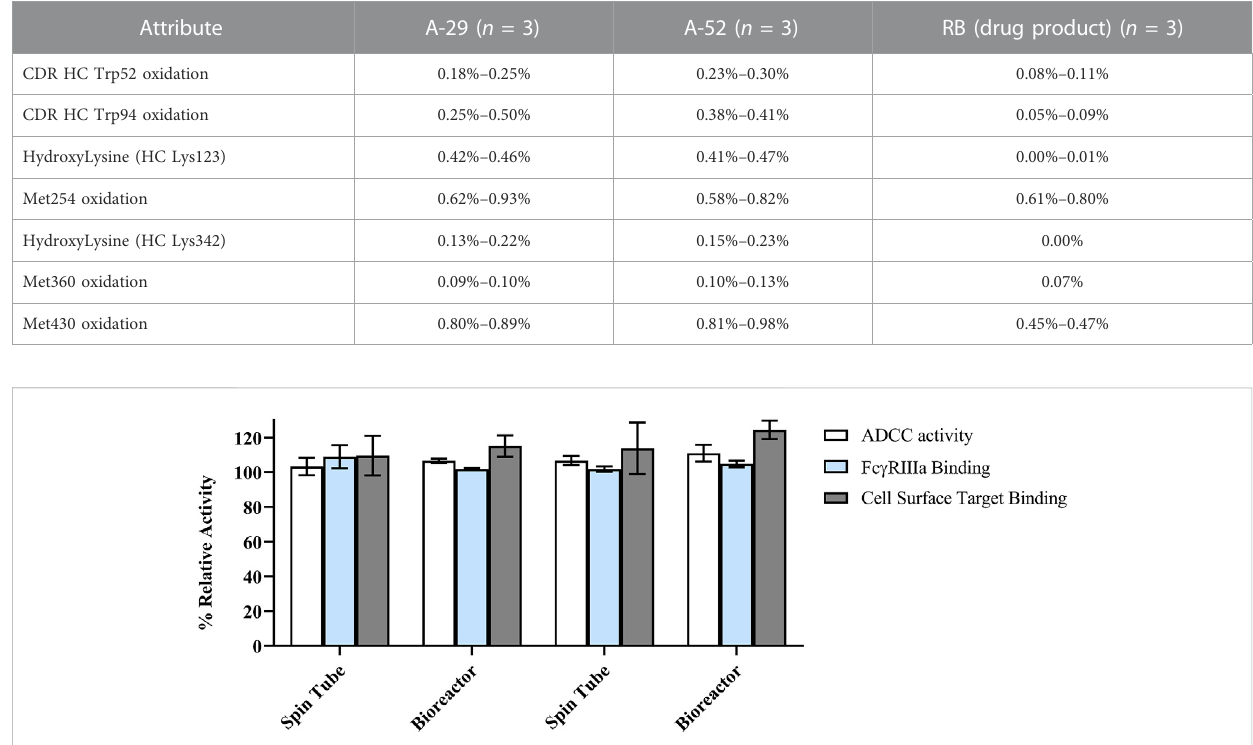
TABLE 3 Chemical modi fi cations of amino acid residues were evaluated. Site speci fi c amino acid modi fi cations were con fi rmed based on the fragmentation of the RB and clones A-52 and A-29. n = number of replicates tested.